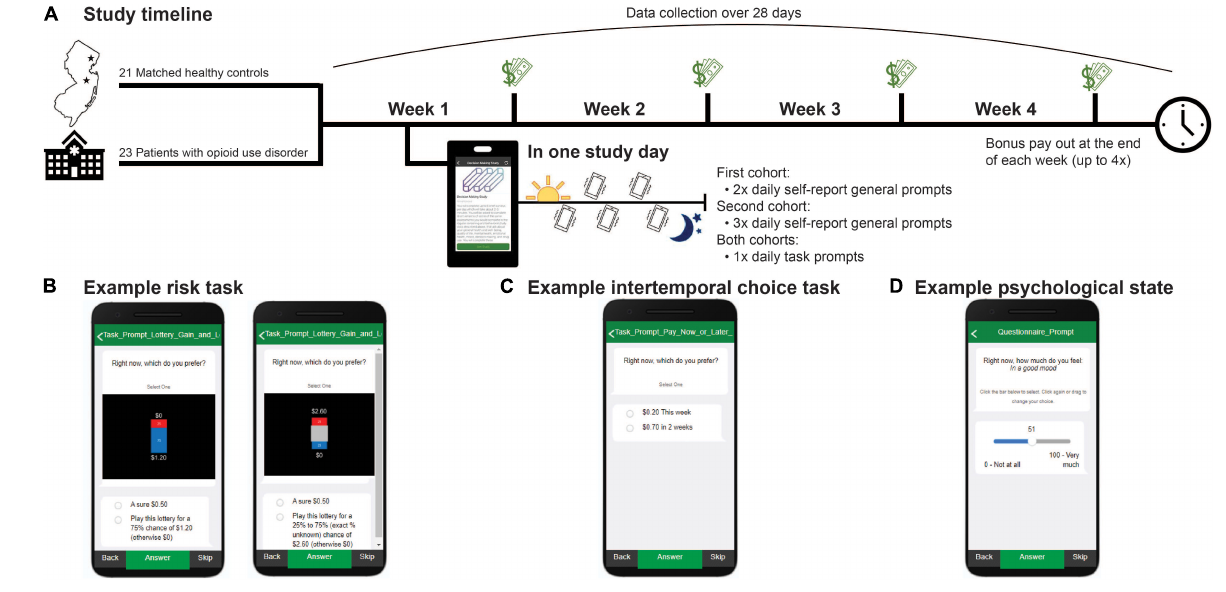
Frontiers in Psychiatry |